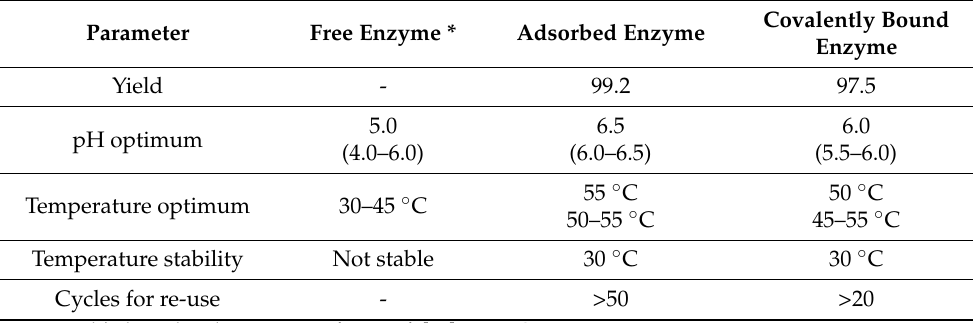
Table 3. Biochemical characteristics of ACut2-6hp as free, adsorbed, and covalently bound enzyme